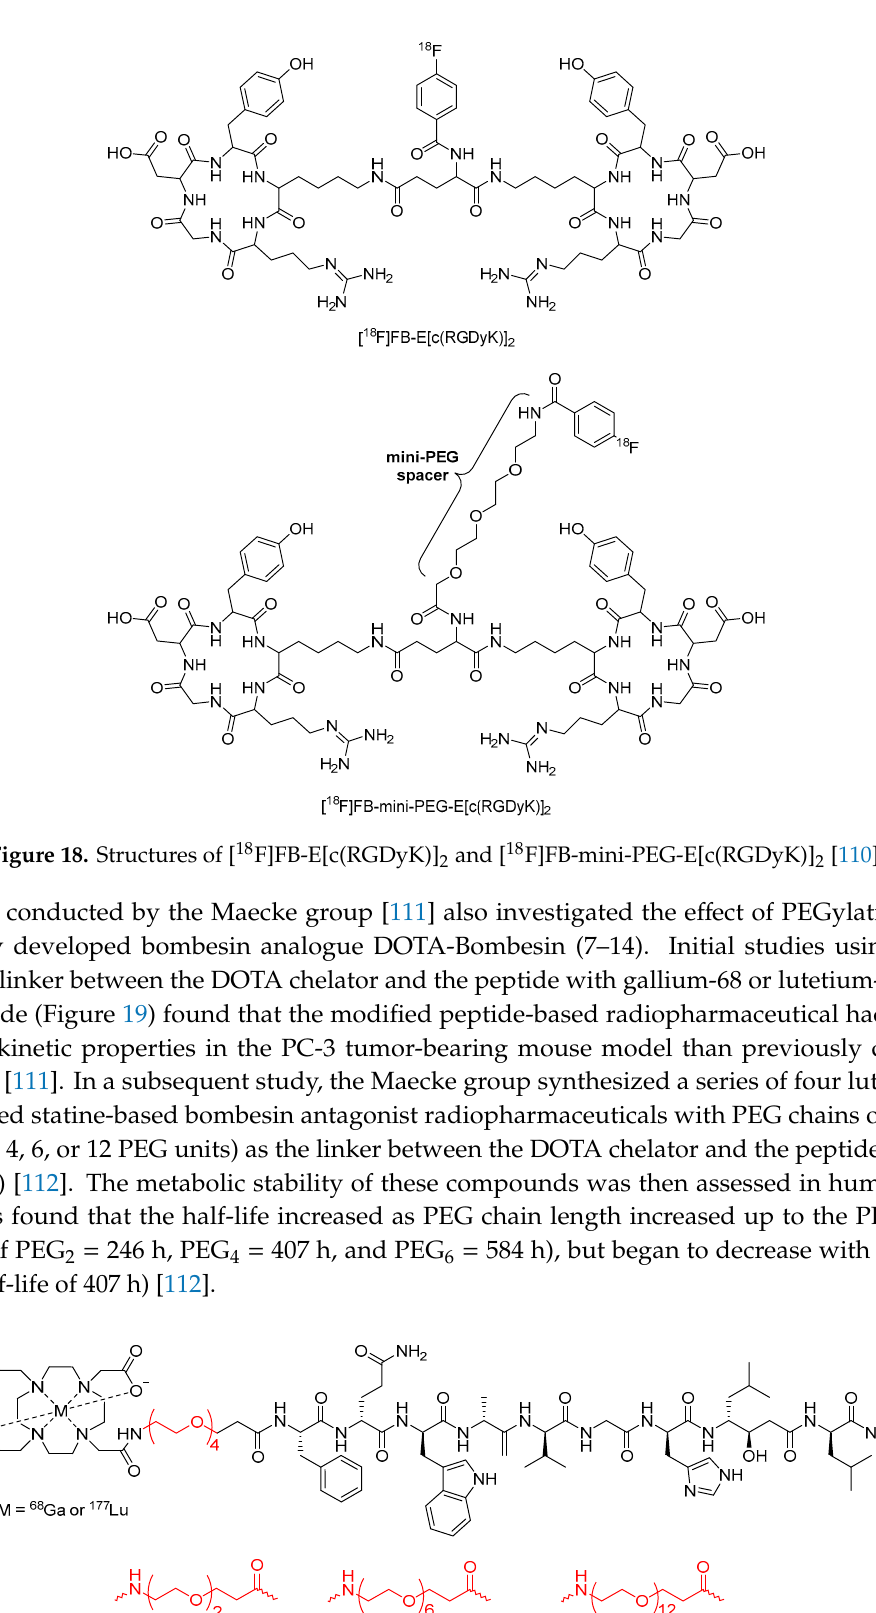
Figure 19. Bombesin-based peptide radiopharmaceutical investigated by the Maecke group, with PEG 4 chain linker and alternative PEG chain lengths highlighted in red [111,112]. chain linker and alternative PEG chain lengths highlighted in red